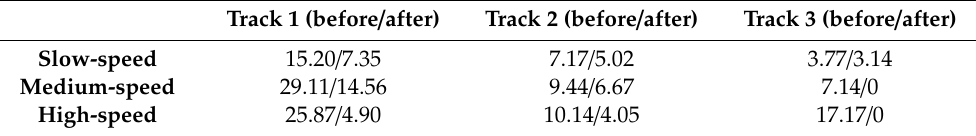
Table 4. MSE (cm) of moving-target positioning experiments. Track 1 (before / after) Track 2 (before / after) Track 3 (before /